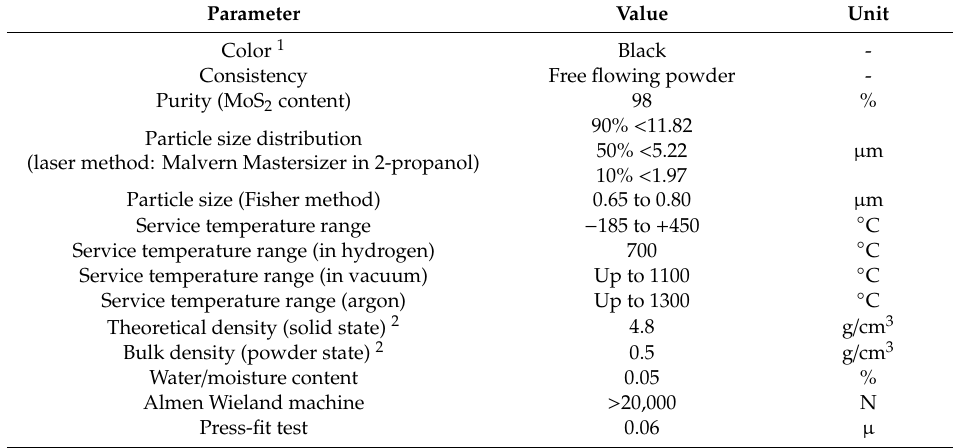
Table 4. Characteristics of the impregnation substance Molykote ® microsize powder. Parameter